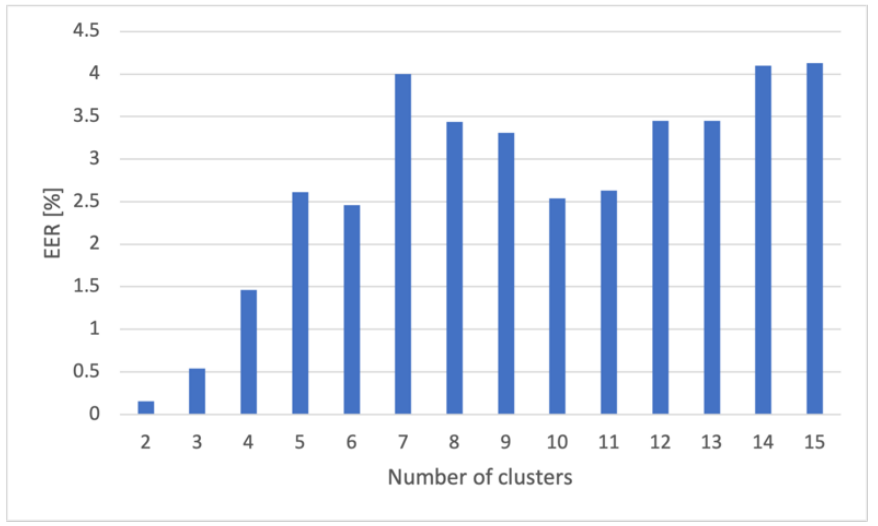
Figure 7. The achieved EER for each cluster number when using SCAD and SVM [17] on the ASVspoof 2017 version 2.0 benchmark dataset .